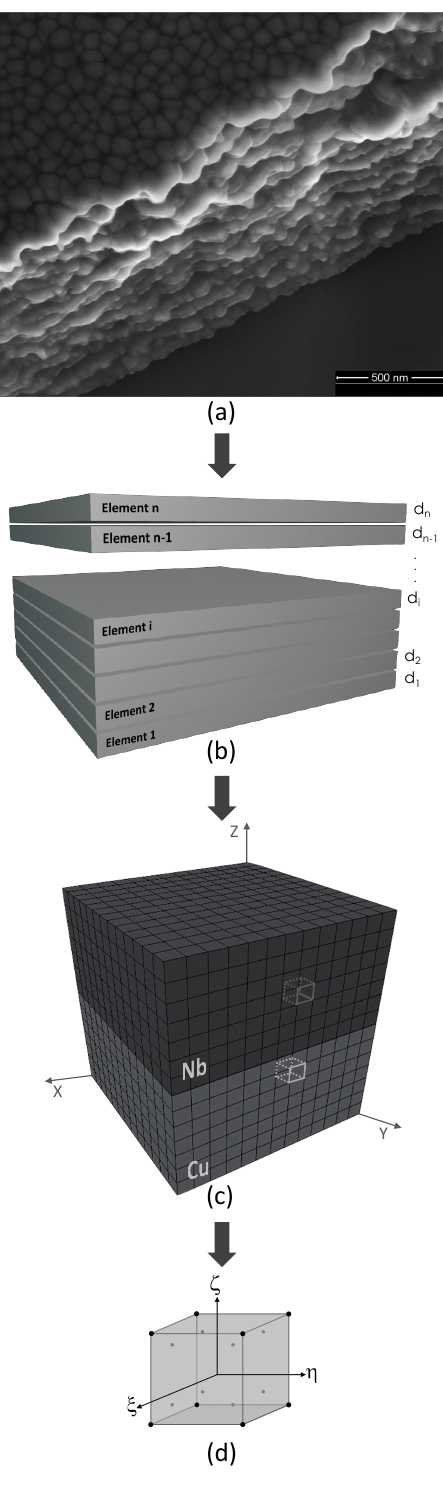
Figure 3. ( a ) A high resolution scanning electron microscopy image of a metallic nano-layer. ( b ) A gen- eralized representative structure of a metallic nano-layer with n elements/layers. ( c ) A 3-dimensional Cu/Nb nano-layer unit cell discretized into ( d ) eight-node hexahedral elements with eight integration points and the local coordinate system of ( ξ , η , ζ )